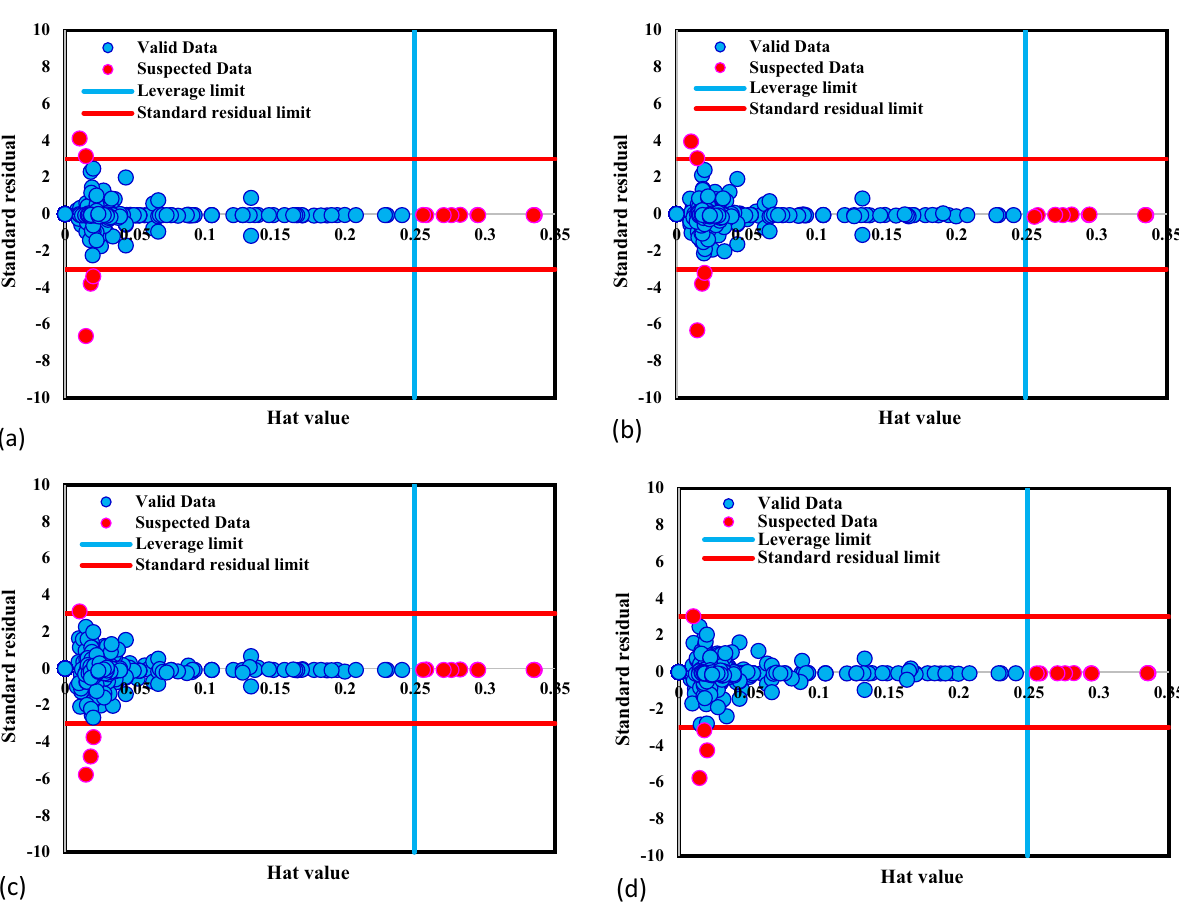
Figure 2. Detection of suspected data for GPR model with kernel function of ( a ) Exponential, ( b ) Matern, ( c ) Squared exponential, ( d ) Rational